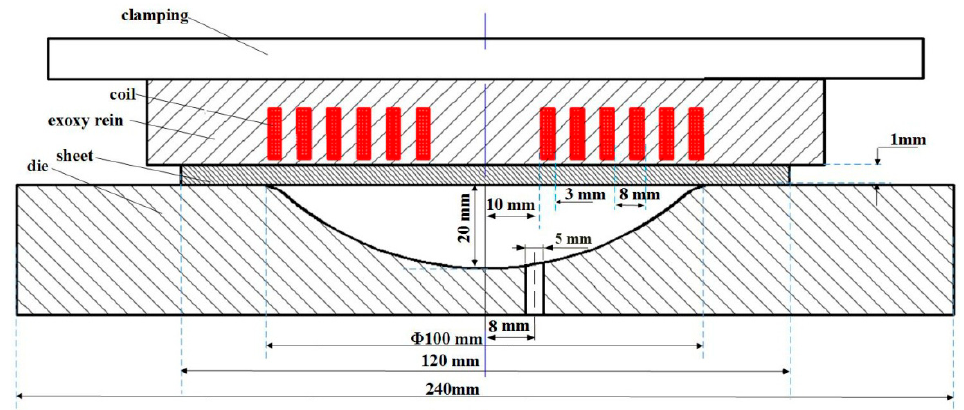
Figure 8. A tool diagram of 5052-O aluminum alloy sheet high-speed electromagnetic impaction with the flat spiral coil.